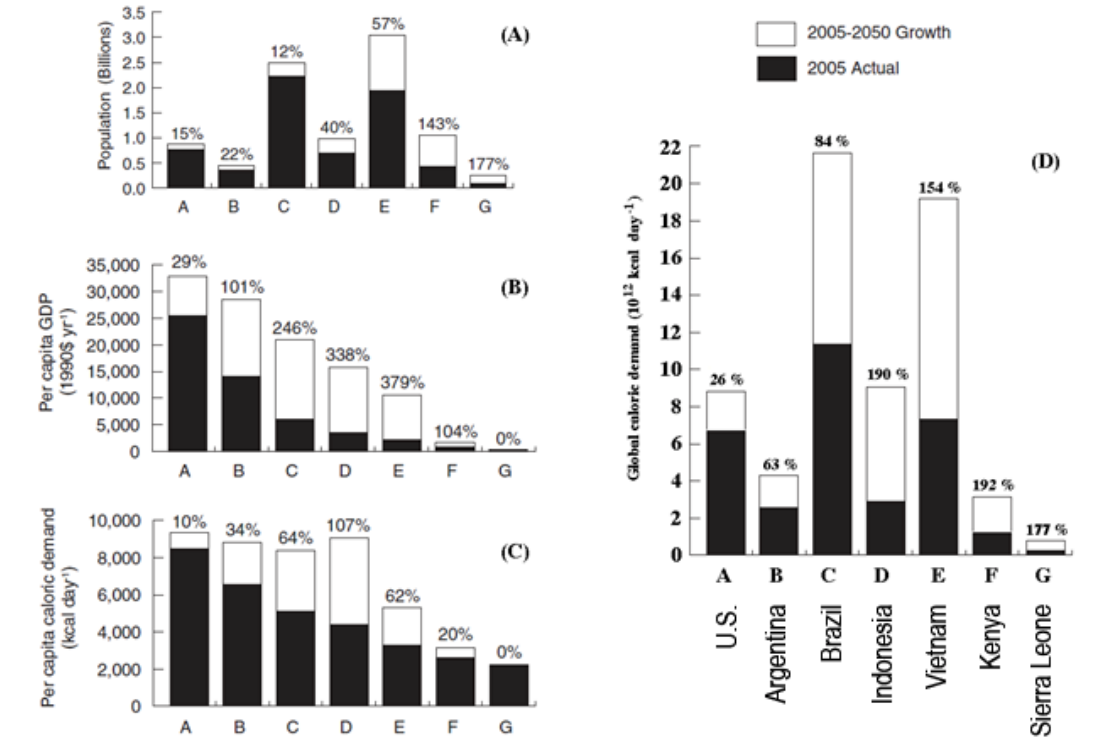
Figure 2. ( A ) Global population, ( B ) per capita Gross Domestic Product (GDP), ( C ) per capita demand for crop calories and ( D ) global demand for crop calories in 2005 (black) and projected 2050 increases (white; percent increases above bars). Nations were assigned to economic groups A–G based on their rankings per capita GDP (average for 2000–2007). Group A had the highest and group G had the lowest per capita GDP ((A–C): [3]; (D): own